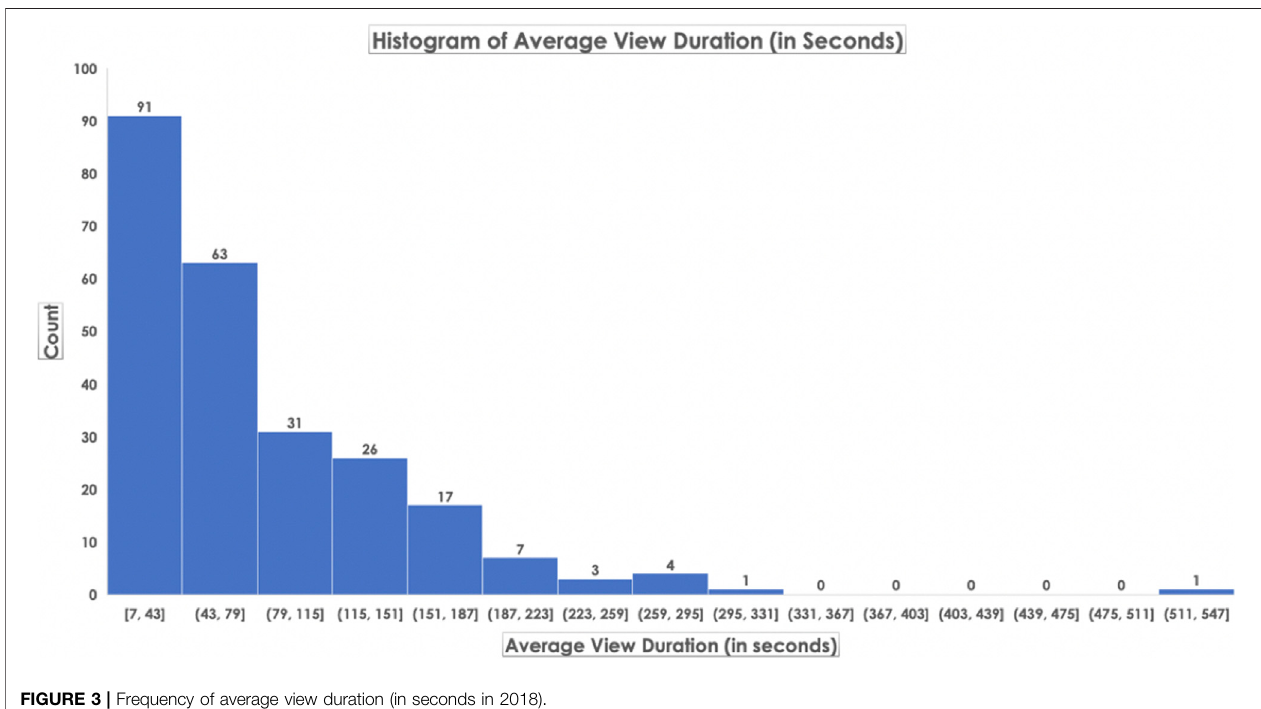
FIGURE 3 | Frequency of average view duration (in seconds in 2018).